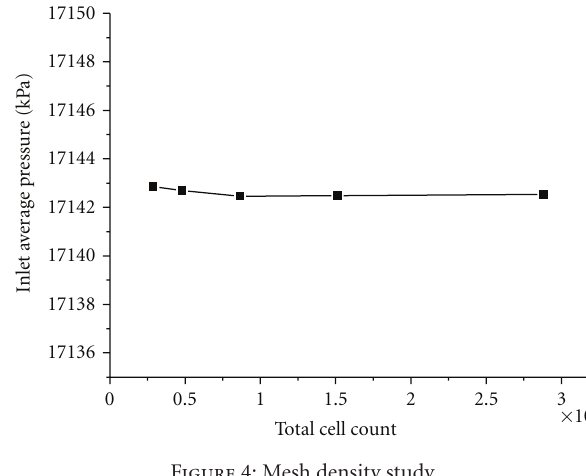
Figure 3: 2D view for the inlet section mesh.